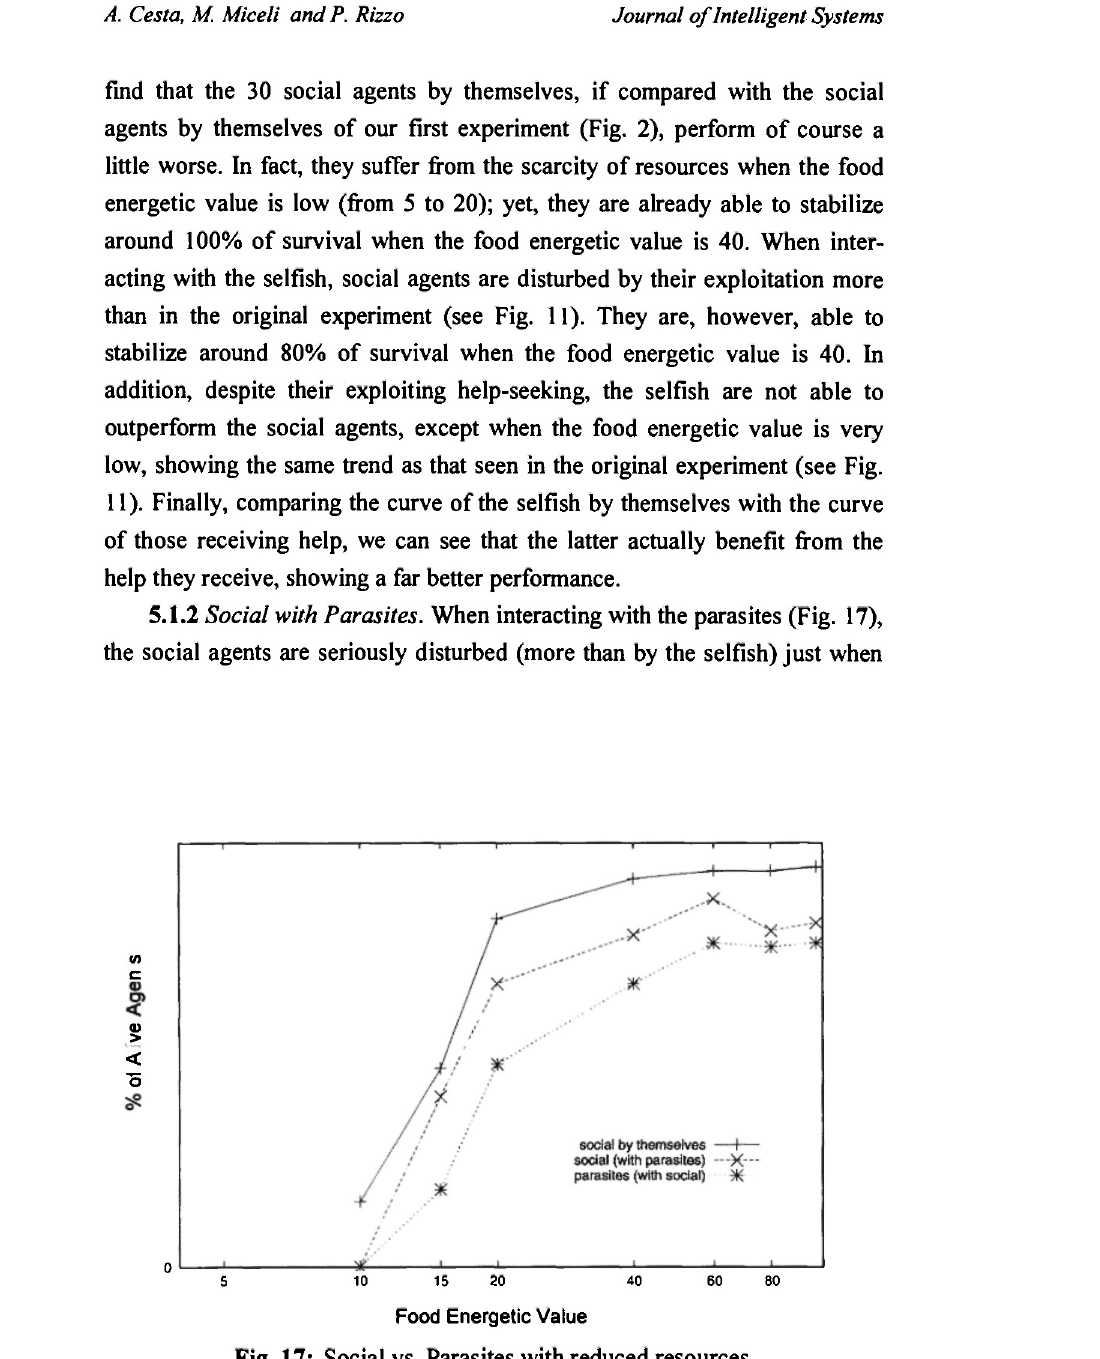
Fig. 17: Social vs. Parasites with reduced